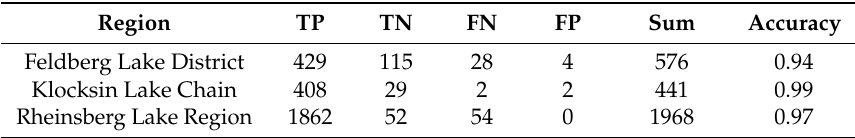
Table 7. Confusion matrices of Landsat-derived calcite precipitation with visual classifications at Feldberg Lake District, Klocksin Lake Chain, and Rheinsberg Lake